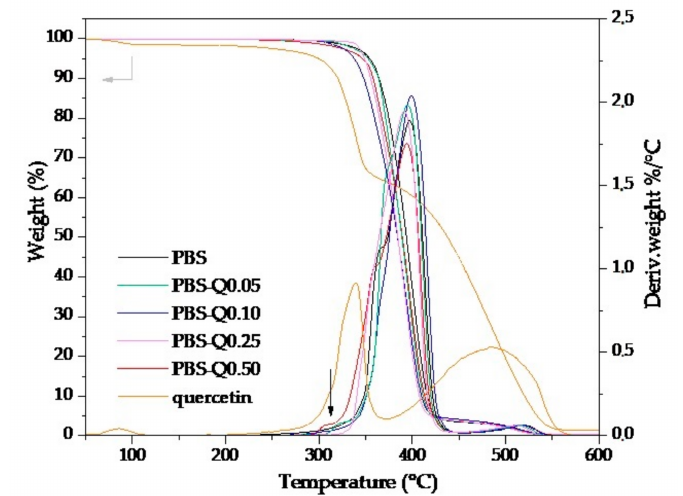
Figure 6. TGA and DTA curves of quercetin and PBS-based